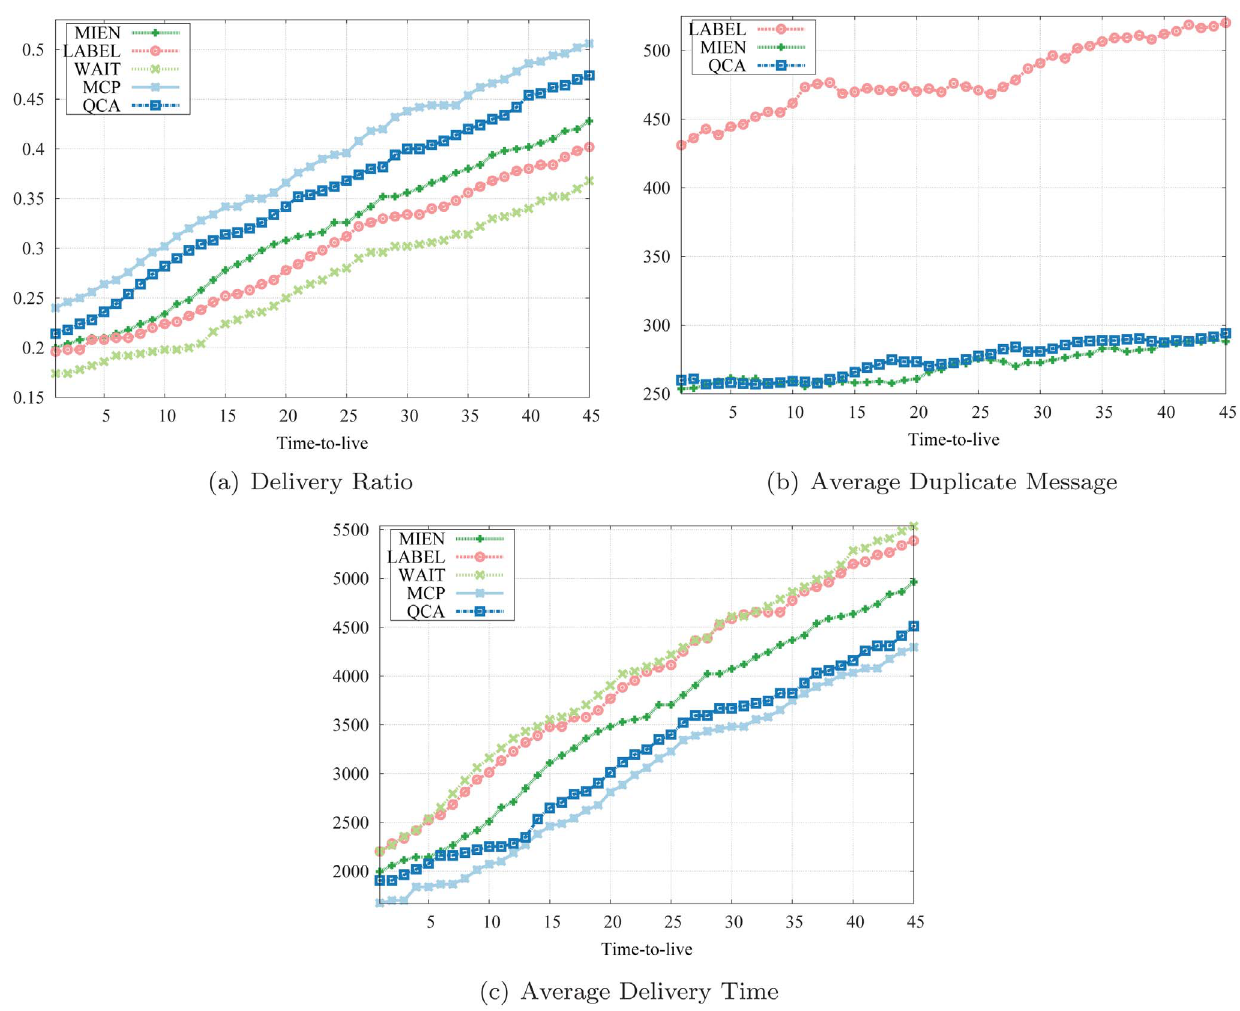
Figure 8. Experimental results on the Reality Mining data set.